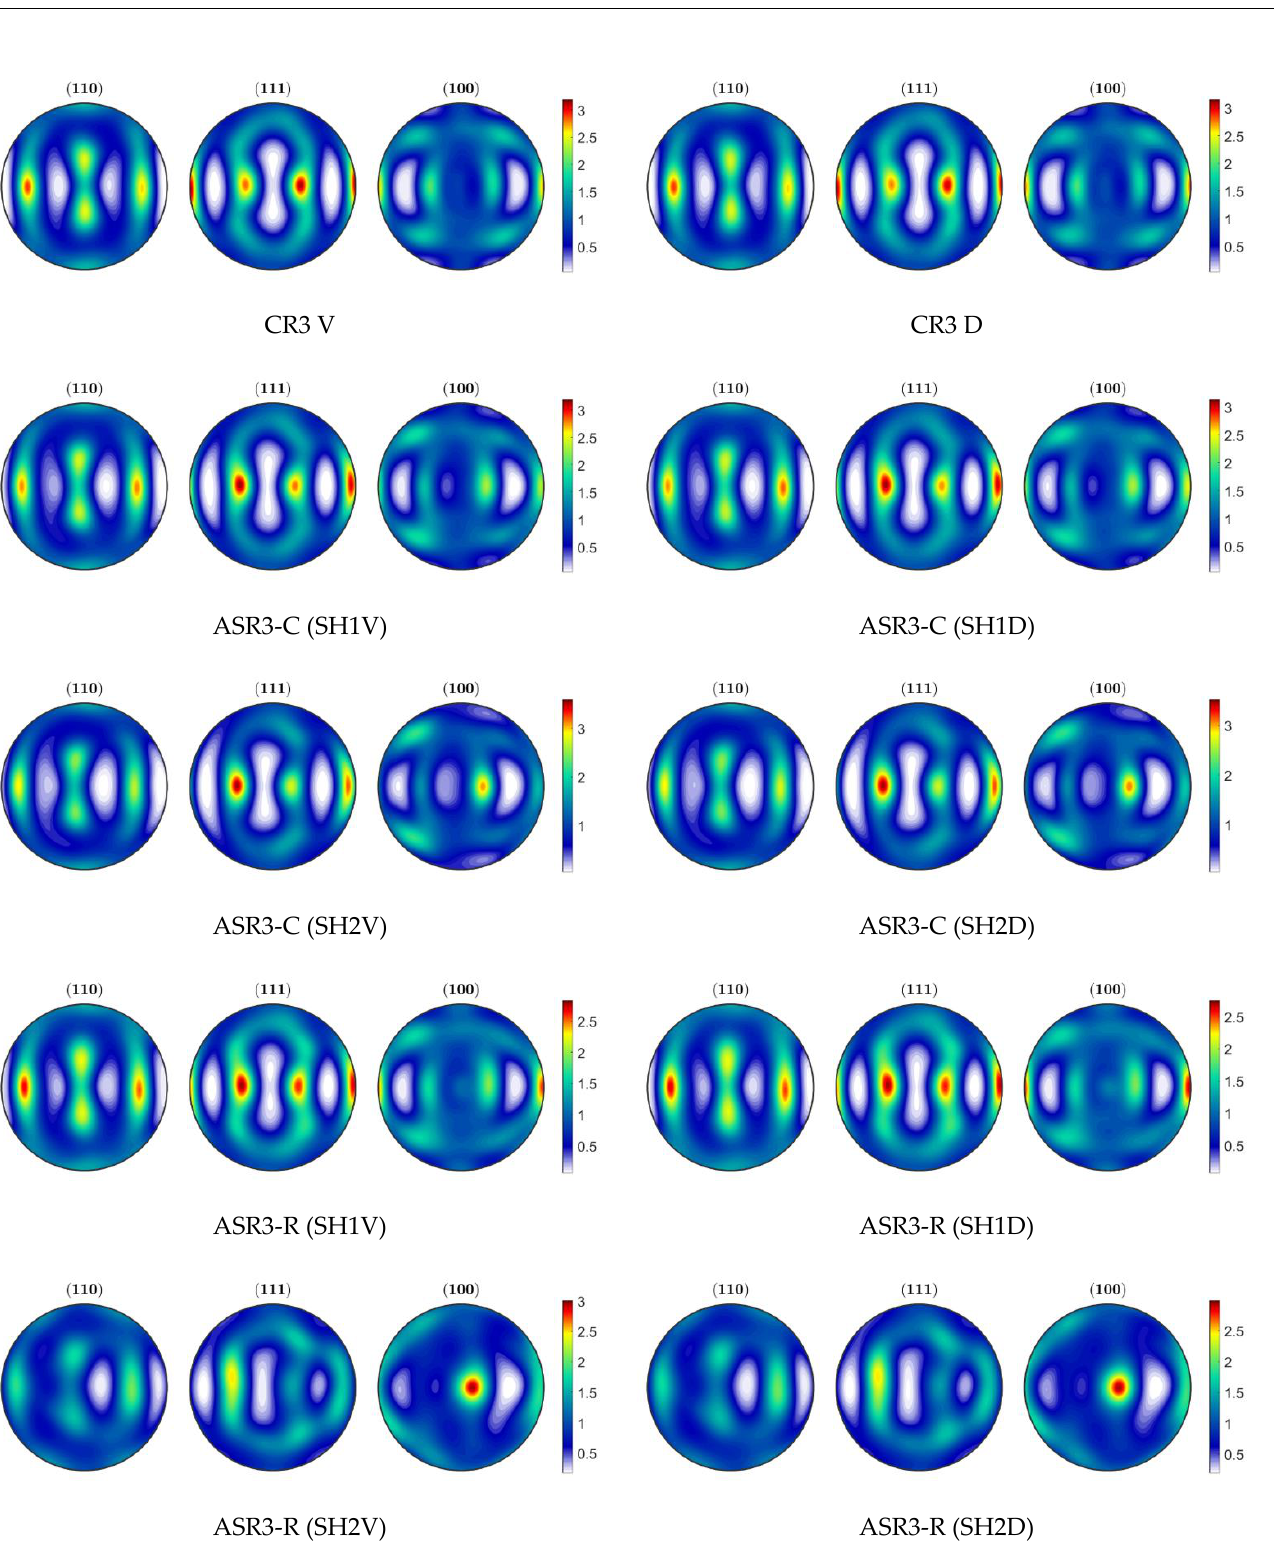
Figure A5. ODF sections for the third pass with a 20% thickness reduction per pass.